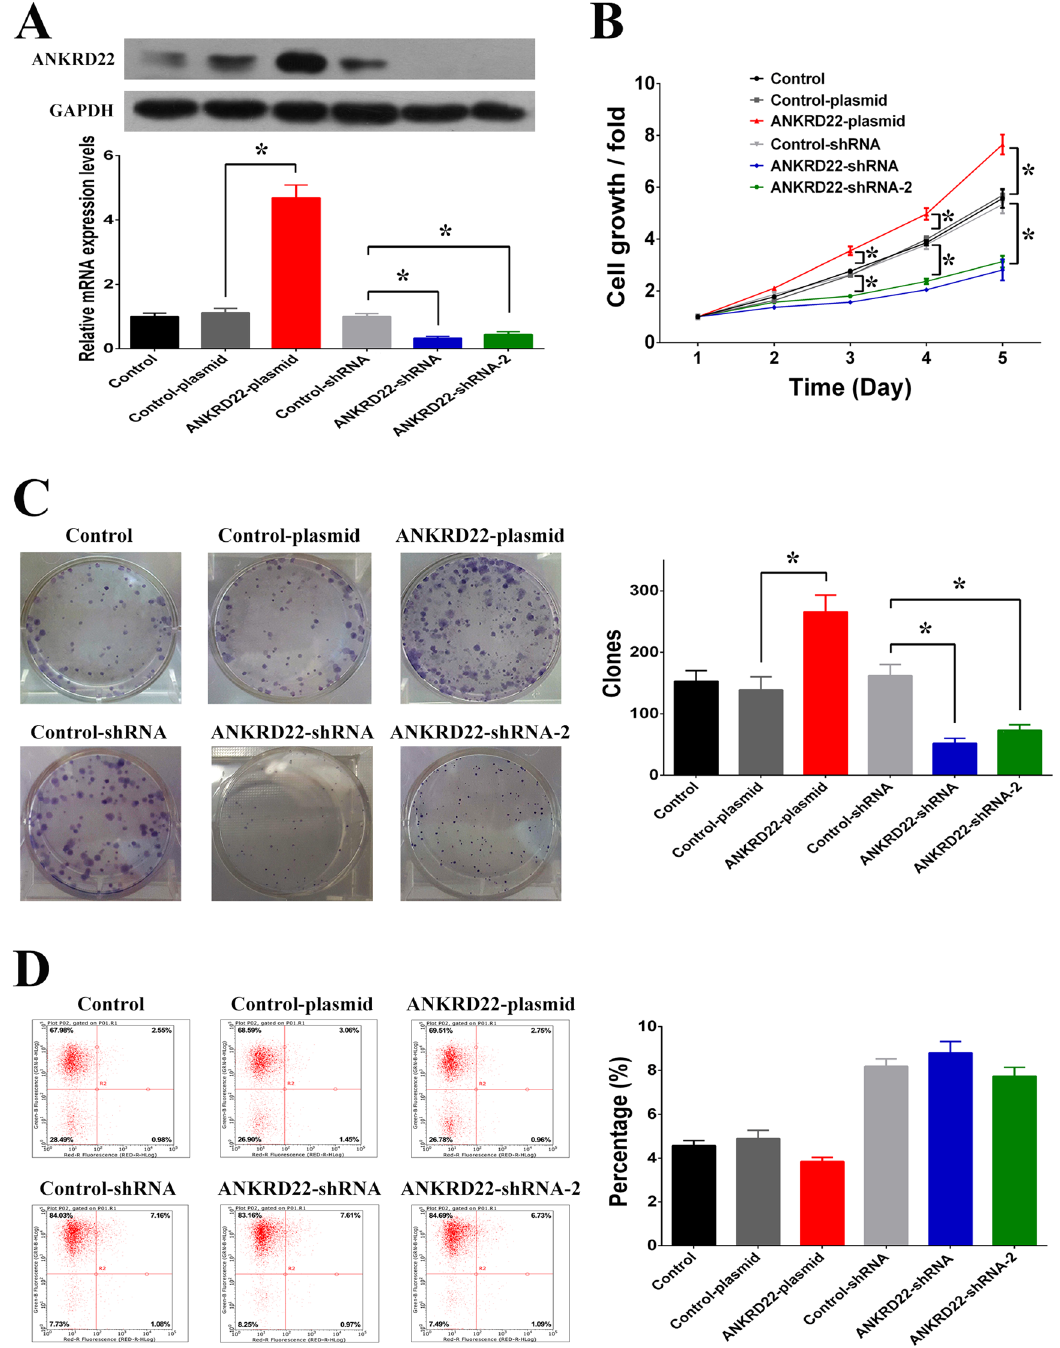
Figure 4. ANKRD22 regulated cell proliferation. ( A ) The mRNA and protein levels of ANKRD22 were increased after transfection with ANKRD22-plasmid and decreased after transfection with ANKRD22-shRNA in H1299 cells. Full-length blots are presented in Supplementary Figure S6. ( B ) Overexpression of ANKRD22 increased cell growth and knockdown of ANKRD22 decreased cell growth in H1299 cells. ( C ) Overexpression of ANKRD22 increased colony formation capacity and knockdown of ANKRD22 decreased colony formation capacity in H1299 cells. ( D ) Overexpression or knockdown of ANKRD22 had no effect on cell apoptosis in H1299 cells. (n = 3, * P <